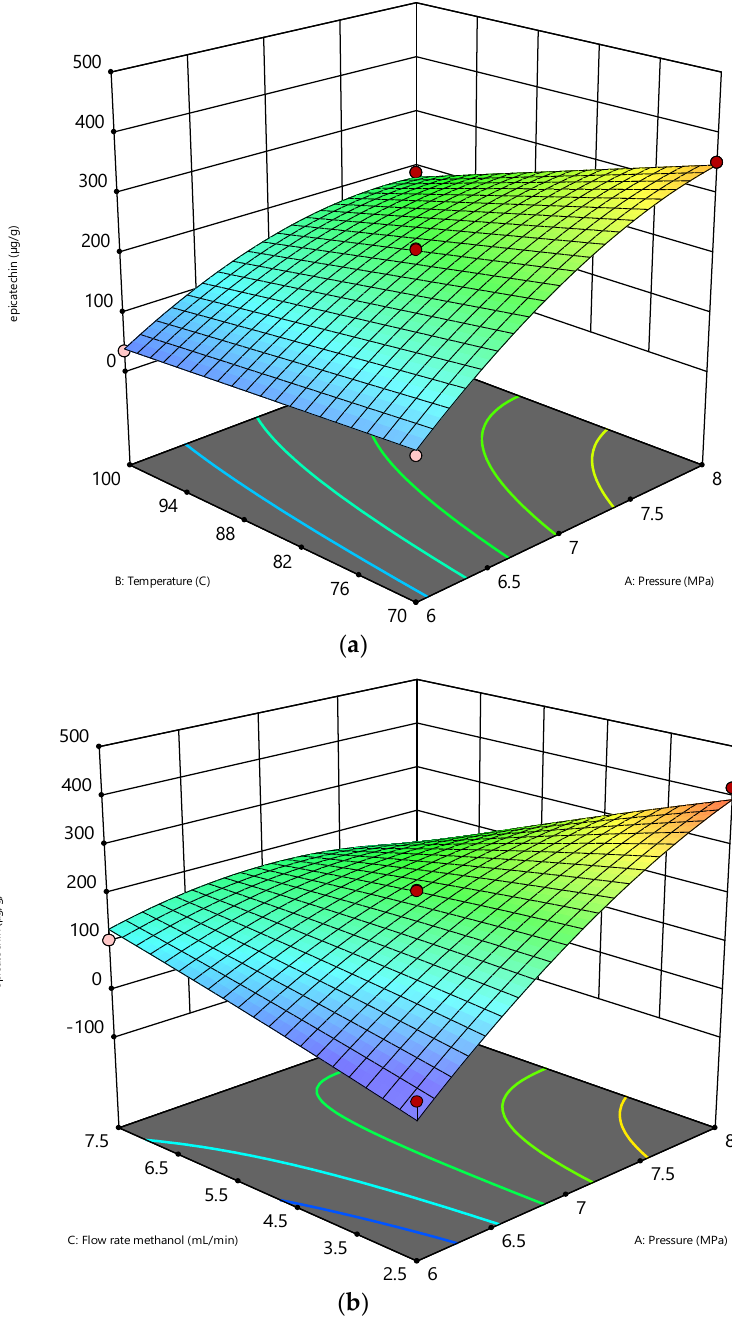
Figure 4. The variables’ effects on epicatechin (µg/g): (a) effect of pressure vs temperature (b) effect of pressure vs flowrate